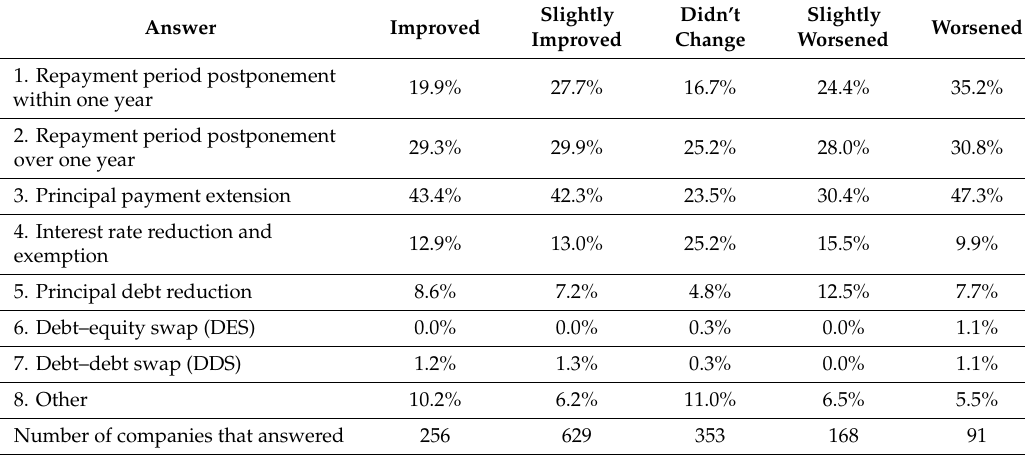
Table 7. Details of condition